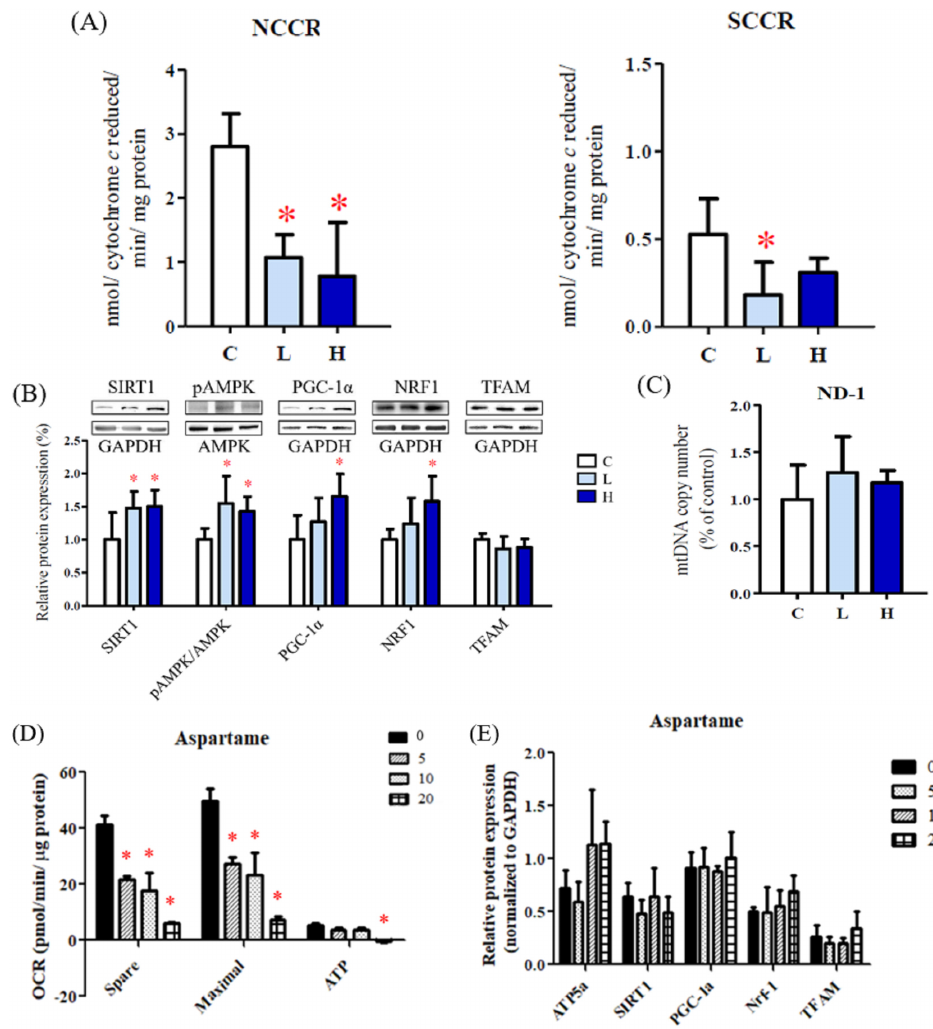
Figure 3. Effect of aspartame treatment on mitochondrial biogenesis and function in rats and cells. Aspartame upregulates mitochondrial biogenesis as a compensatory mechanism to make up for poor mitochondrial function. ( A ) NCCR, mitochondrial complex I and III activities and SCCR, mitochondrial complex II and III activities (n = 5). ( B ) The mitochondrial biogenesis-related protein levels in ovary (n = 5). ( C ) The mitochondrial DNA copy numbers of ovary (n = 5). Data are normalized with GAPDH. Oxygen consumption rate (OCR) was monitored using the seahorse XFe-24 analyzer with the sequential injection of oligomycin, carbonyl cyanide-p-trifluoromethoxy phenylhydrazone (FCCP), and rotenone/antimycin. ( D ) After analyzing, the maximal respiration, spare respiratory capacity and ATP production in KGN cells (n = 3) were calculated. ( E ) The mitochondrial biogenesis-related protein levels in KGN cells treated with 5–20 mM aspartame for 48 h (n = 3). Data are normalized with GAPDH. SIRT1 (120 kDa); AMPK (62 kDa); PGC-1 α (95 kDa); NRF1 (54 kDa); TFAM (28 kDa); ATP5 α (60 kDa). All data are expressed as mean ± SD. * p < 0.05 as compared with control. C, control. L, low dose of aspartame. H, high dose of aspartame. NCCR, nicotinamide adenine dinucleotide–cytochrome c reductase. SCCR, succinate-cytochrome c reductase. SIRT1, NAD-dependent deacetylase sirtuin-1. AMPK, AMP-activated protein kinase. PGC, peroxisome proliferator-activated receptor-gamma coactivator. NRF1, nuclear respiratory factor 1. TFAM, mitochondrial transcription factor A. ND-1, NADH-ubiquinone oxidoreductase chain 1. 0, 0 mM; 5, 5 mM; 10, 10 mM; 20, 20 mM.